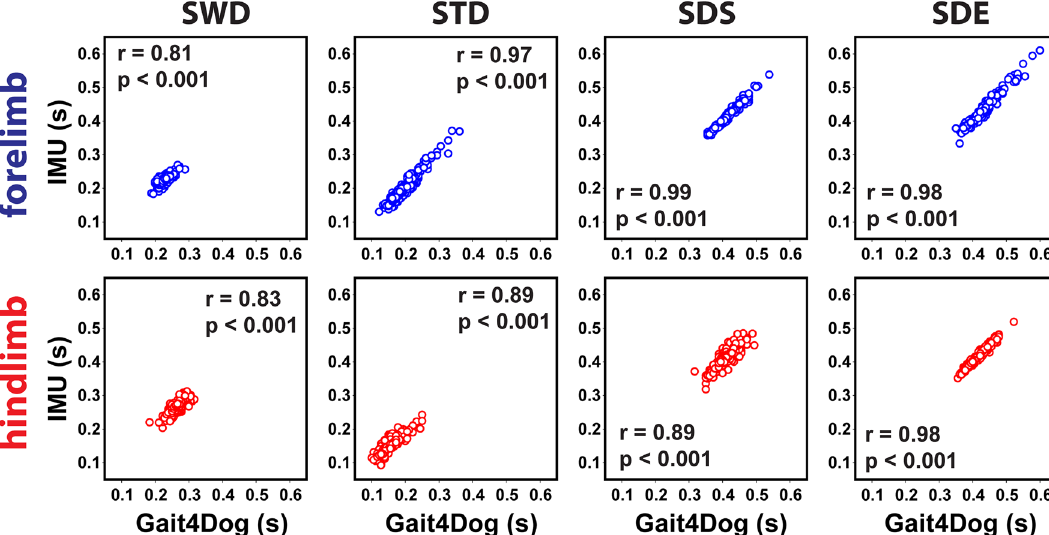
Figure 4. Pearson’s correlation of the four gait parameters (Eq. (1)) obtained from the IMU (vertical axes) and GAIT4Dog (horizontal axes) systems in the synchronized validation study. The correlation coefficient r and p values are given in each pairwise plot. SWD, swing duration; STD, stance duration; SDS, stride duration based on swing start; SDE, stride duration based on swing